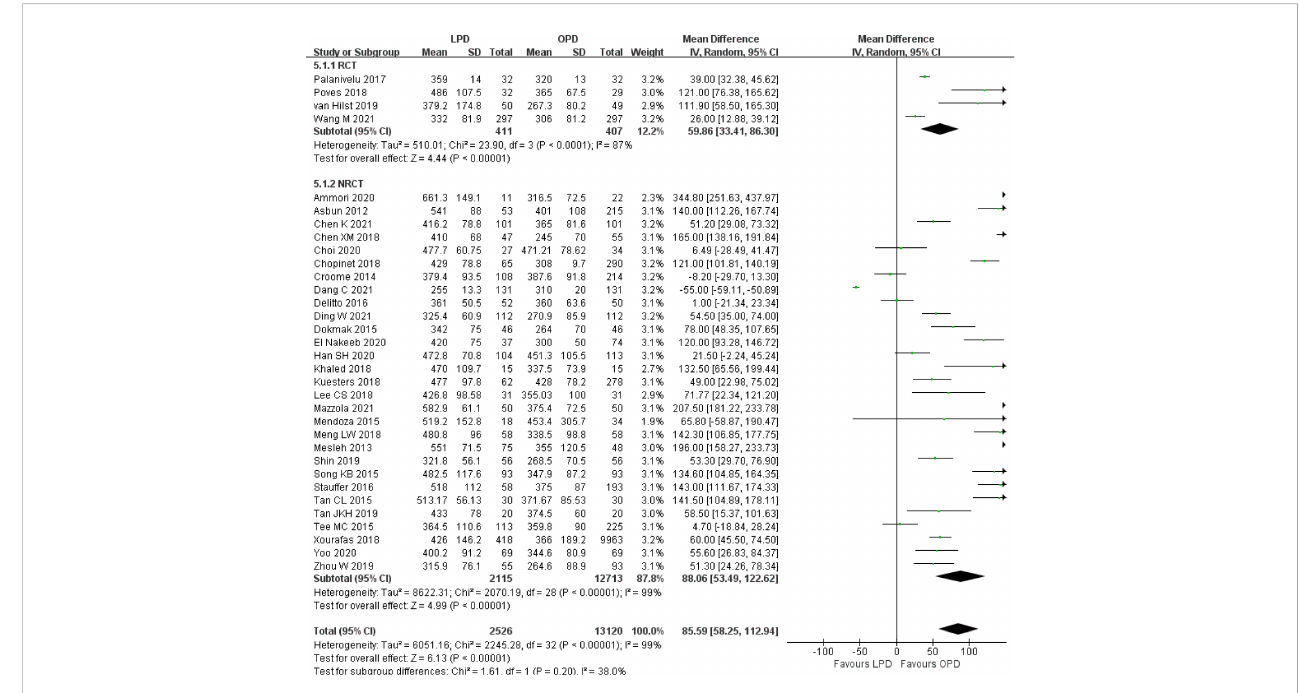
FIGURE 5 Forest plot of comparison between LPD and OPD on operative time. LPD, laparoscopic pancreaticoduodenectom; OPD, open pancreaticoduodenectomy.